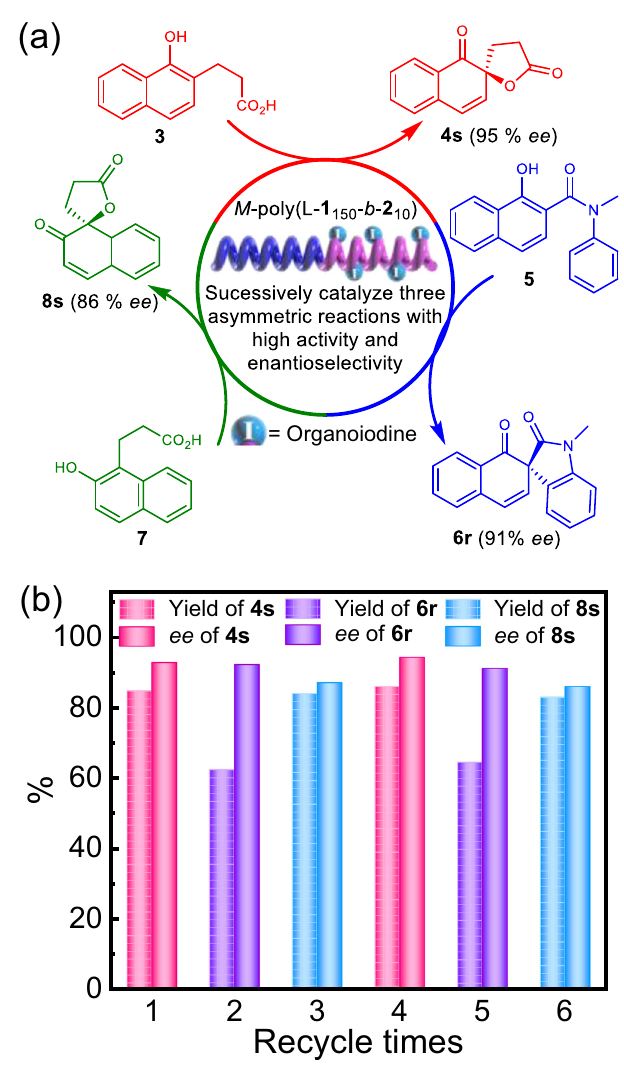
Fig. 4 | Cartoon diagram and results of catalyst cross catalyzing multiple reactions. a Recycling and successively catalyzed three different asymmetric reactions of 3 , 5 , and 7 using M -poly(L- 1 150 - b - 2 10 ) catalyst. b Yields and ee values of 4s , 6r , and 8s , obtained from the asymmetric reactions of 3 , 5 , and 7 catalyzed by recycled M -poly(L- 1 150 - b - 2 10